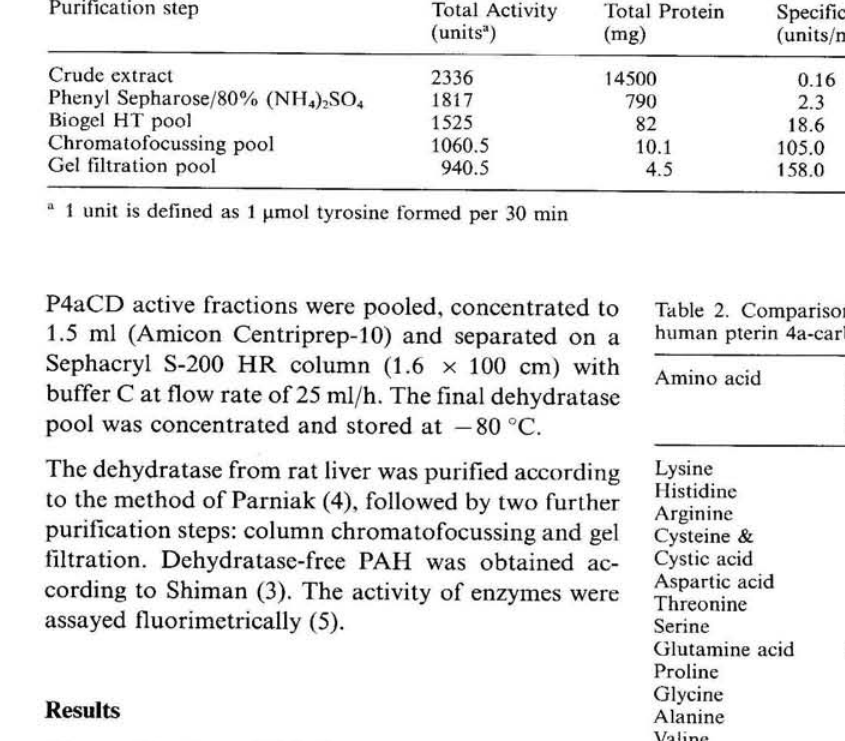
Table 1. Purification of pterin 4a-carbinolamine dehydratase from human liver. Purification step